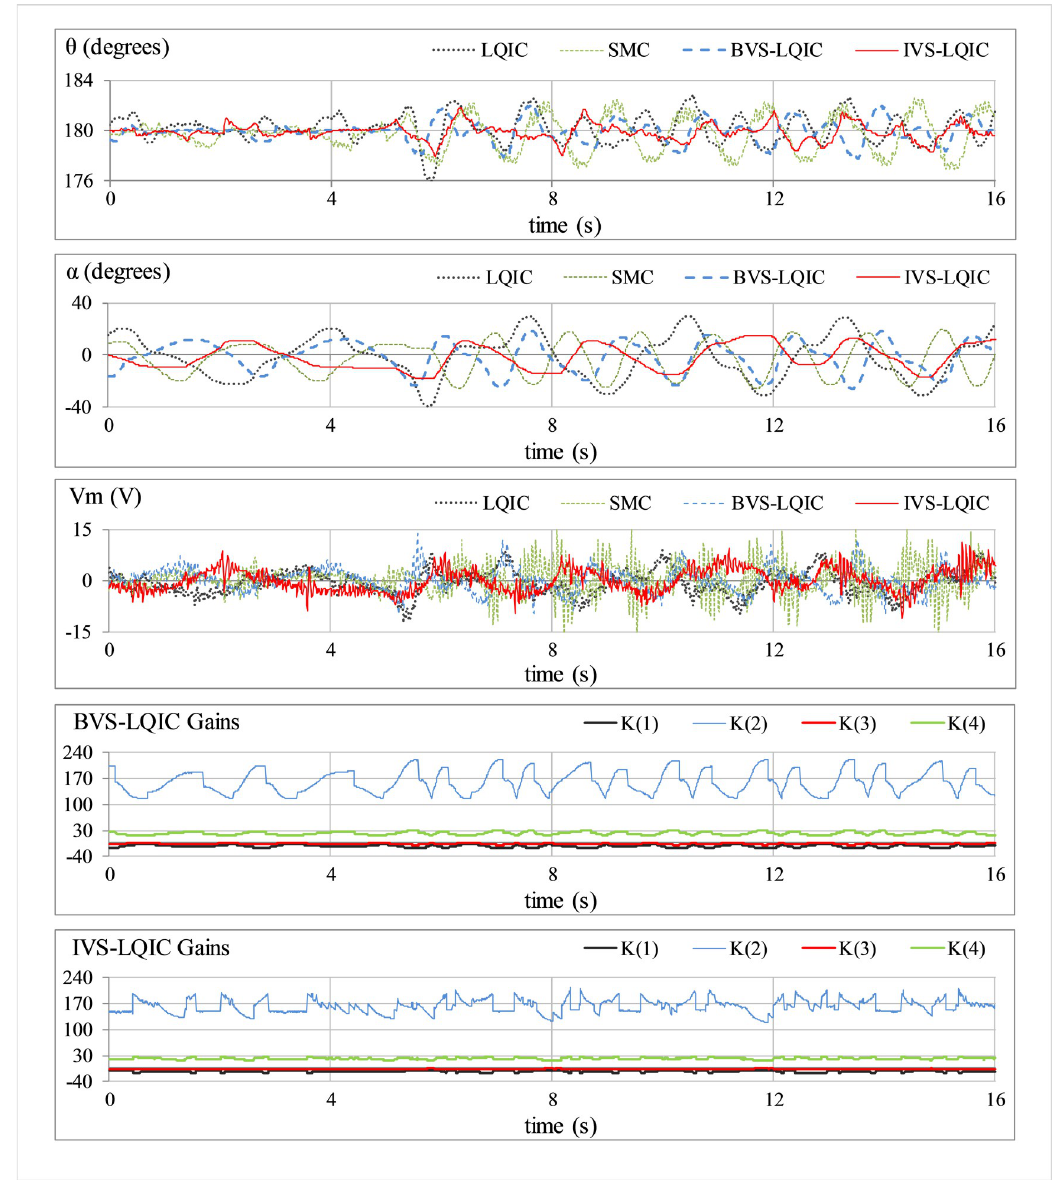
Fig 11. Pendulum’s response under model